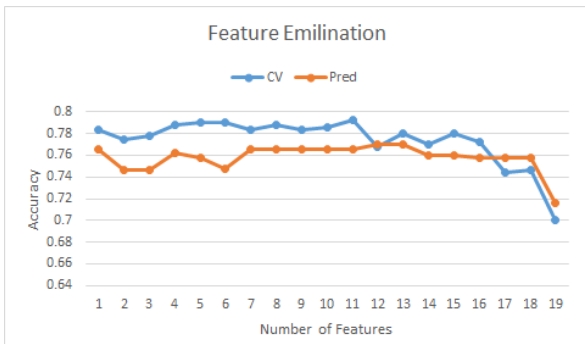
Figure. 5. Accuracy in case of German credit dataset